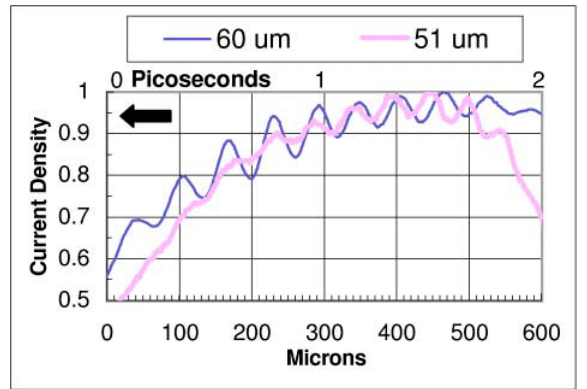
FIG. 6. (Color) Normalized beam current density with mi- crobunching at 60 and 51 m m. These data were averaged from 60 horizontal slices through images like Fig. 5. Note that the modulation amplitude varies along the electron bunch. The ar- row indicates the direction of bunch